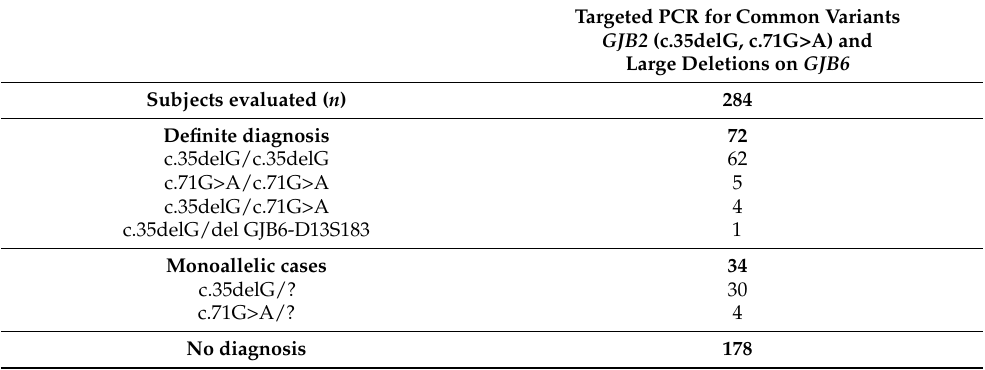
Figure 1. Diagnosis workflow in our study: 284 cases underwent targeted testing; 124 of them accepted to have sequencing of GJB2 exon 2 and MLPA-P163 testing performed. PCR—polymerase chain reaction, SEQ—sequencing, MLPA—multiplex-ligation-dependent probe amplification. Table 1. Diagnosis results for using targeted PCR for common variants as first-tier diagnostic means.